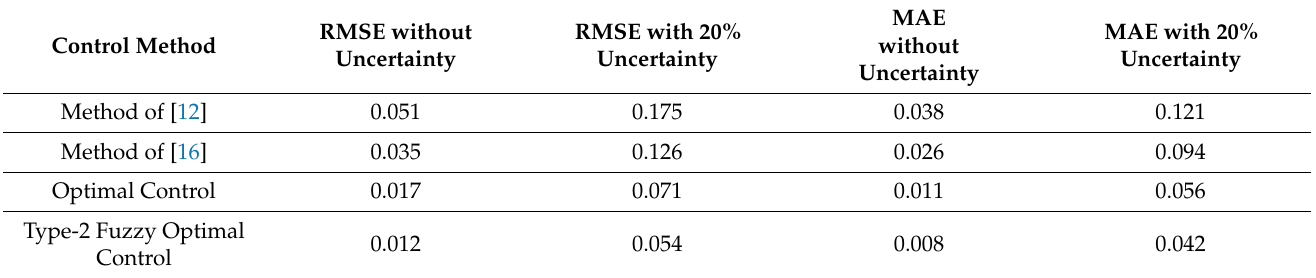
Table 1. Comparison of control methods based on the RMSE